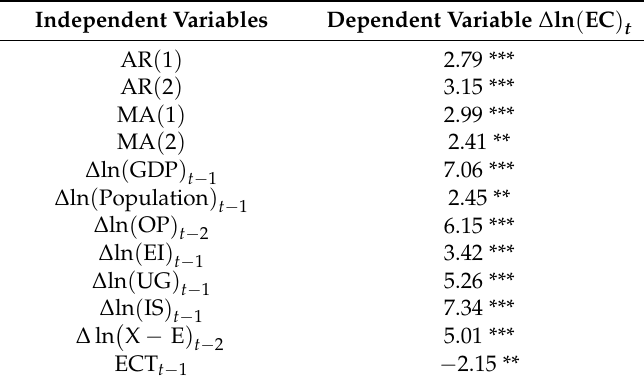
Table 3. The result of the LT-ARIMAXS model